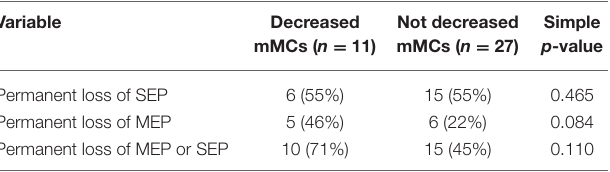
TABLE 7 | Neurophysiological predictors of decreased long-term functional outcome following resection of intramedullary spinal tumors (excluding patients w/o